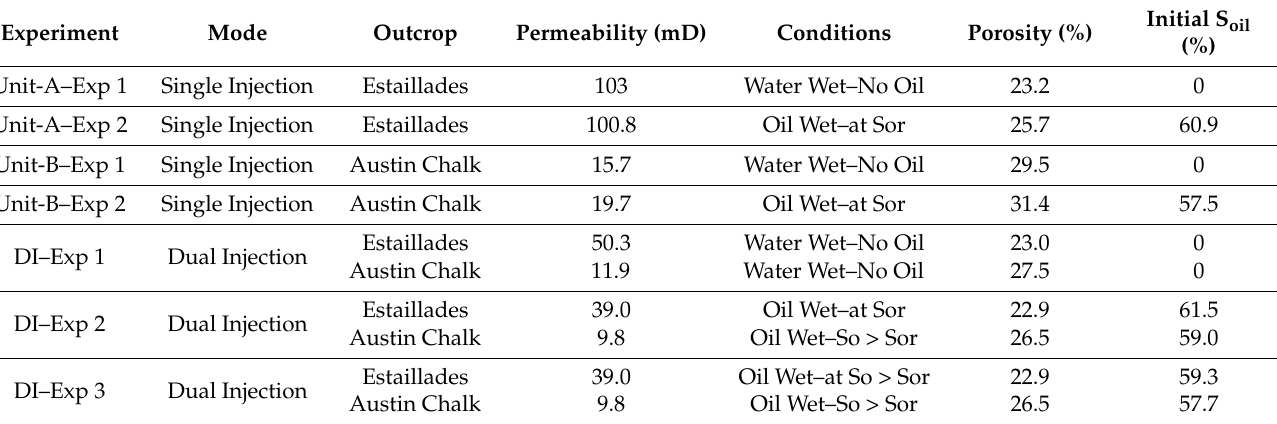
Table 3. List of core flood